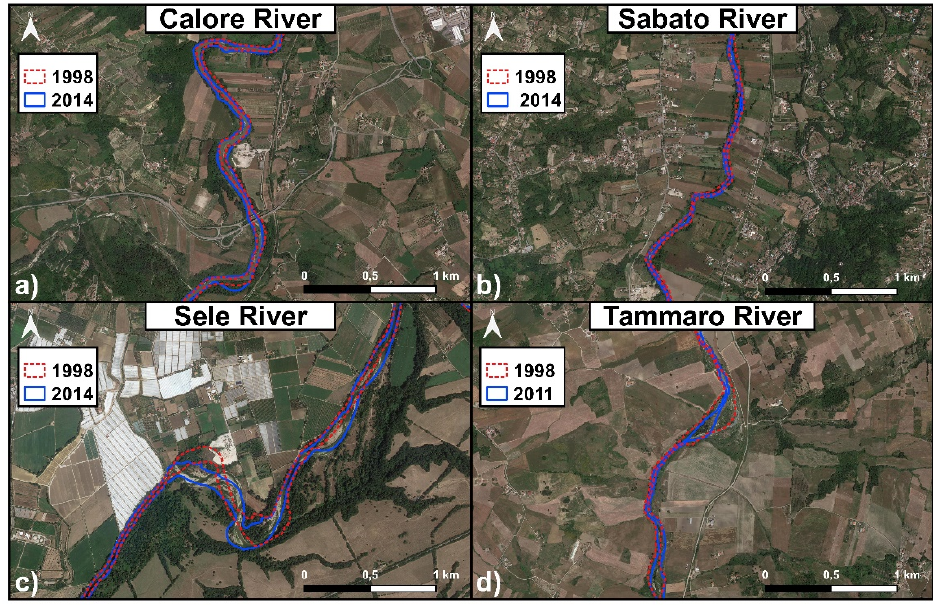
Figure 6. Geomorphological sketches of some selected river stretches showing channel width vari- ations during Phase 3. variations during Phase